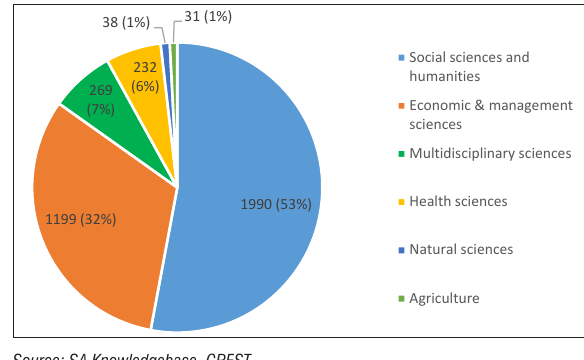
Figure 2: Distribution of predatory articles (number, percentage) classified as probably predatory (strong evidence) by subject